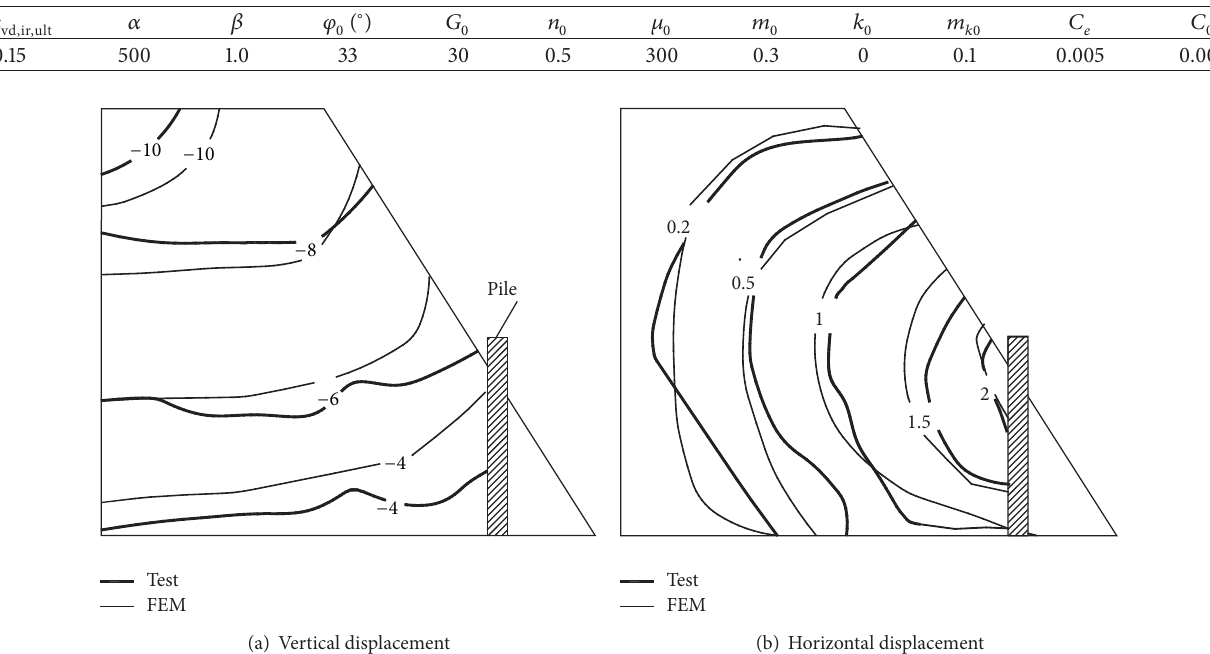
Table 2: EPDI model parameters of the interface.